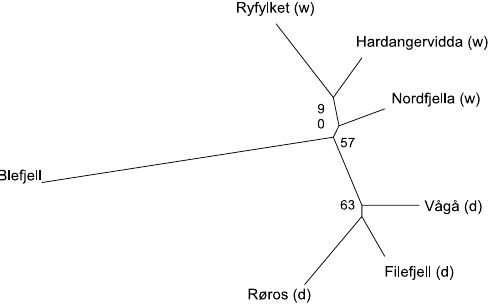
Fig. 4. Unrooted Neighbour Joining tree based on pairwise genetic distances (D between the Blefjell A) reindeer herd and three wild reindeer herds (w) and three semi-domestic reindeer herds (d). Bootstrap value of main branching is